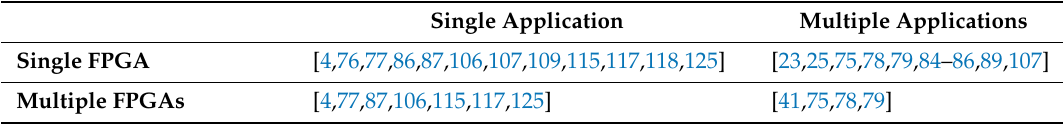
Table 6. Distribution of Works based on Execution